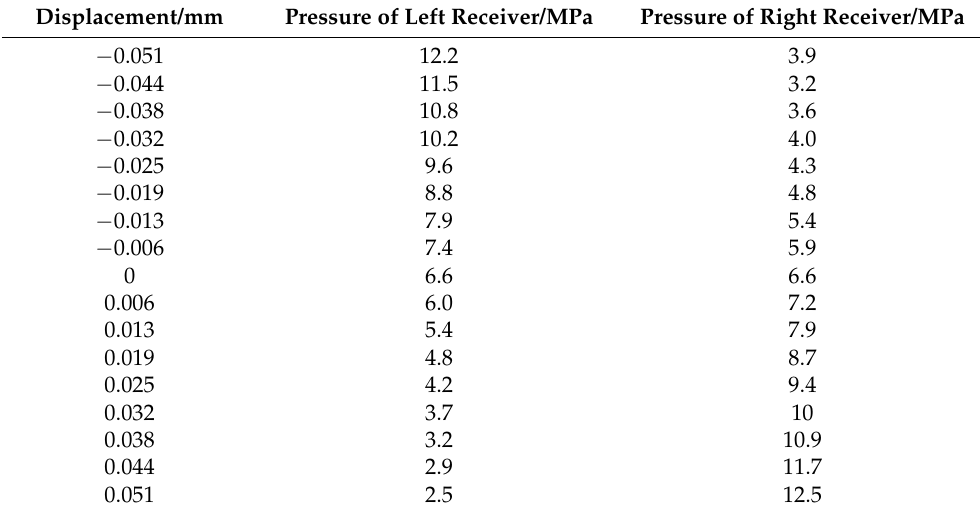
Table A2. Experimental data on receiver